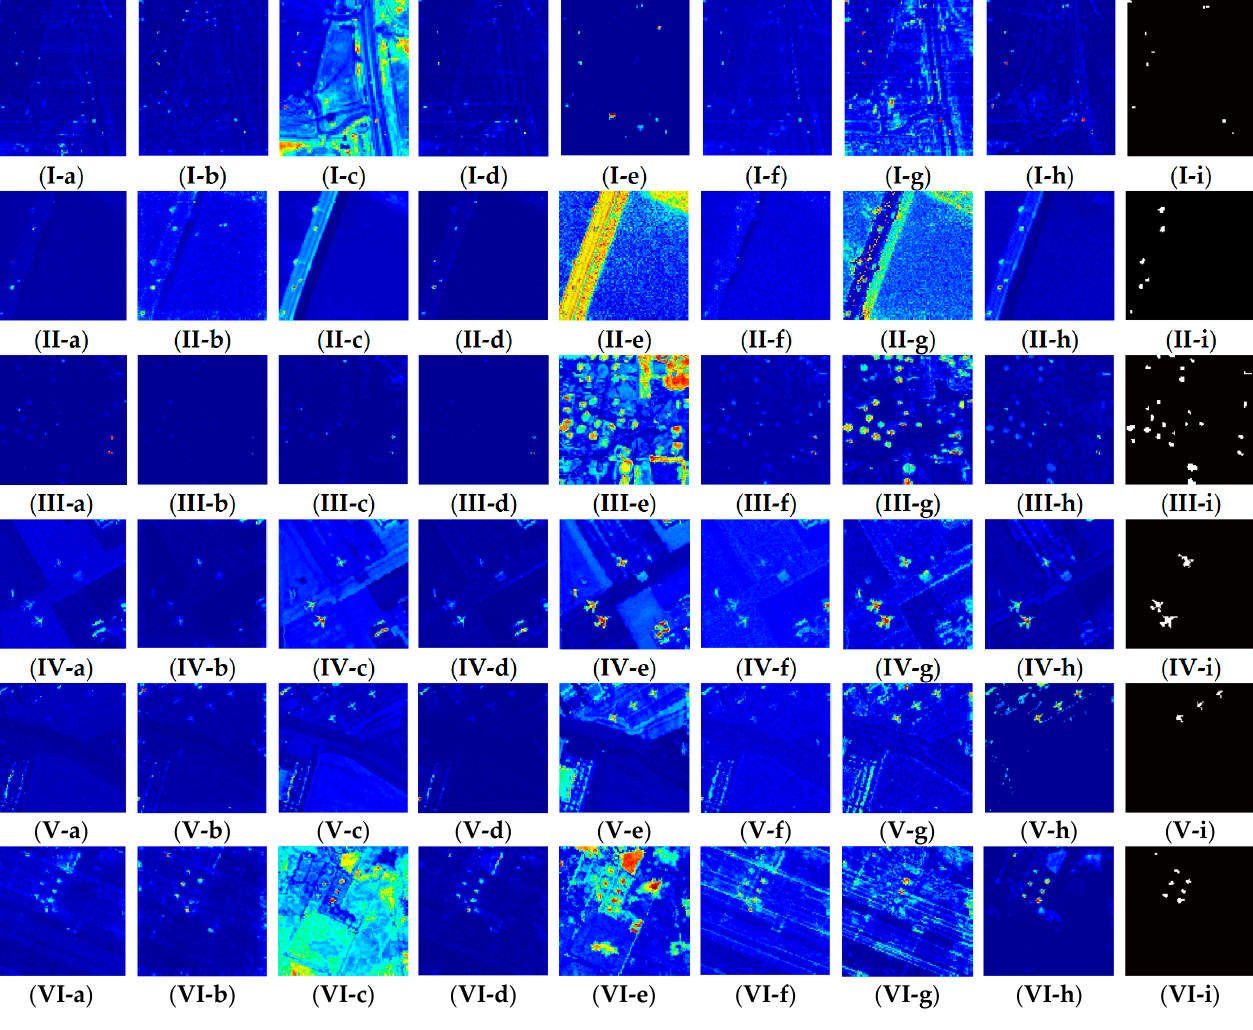
Figure 12. Detection maps of different methods: ( I ) HYDICE, ( II ) Pavia, ( III ) Los Angeles, ( IV ) San Diego-I, ( V ) San Diego-II and ( VI ) Texas Coast. ( a ) RX, ( b ) CRD, ( c ) LRASR, ( d ) LSMAD, ( e ) PAB-DC, Table 3. AUC values on different methods over five datasets.